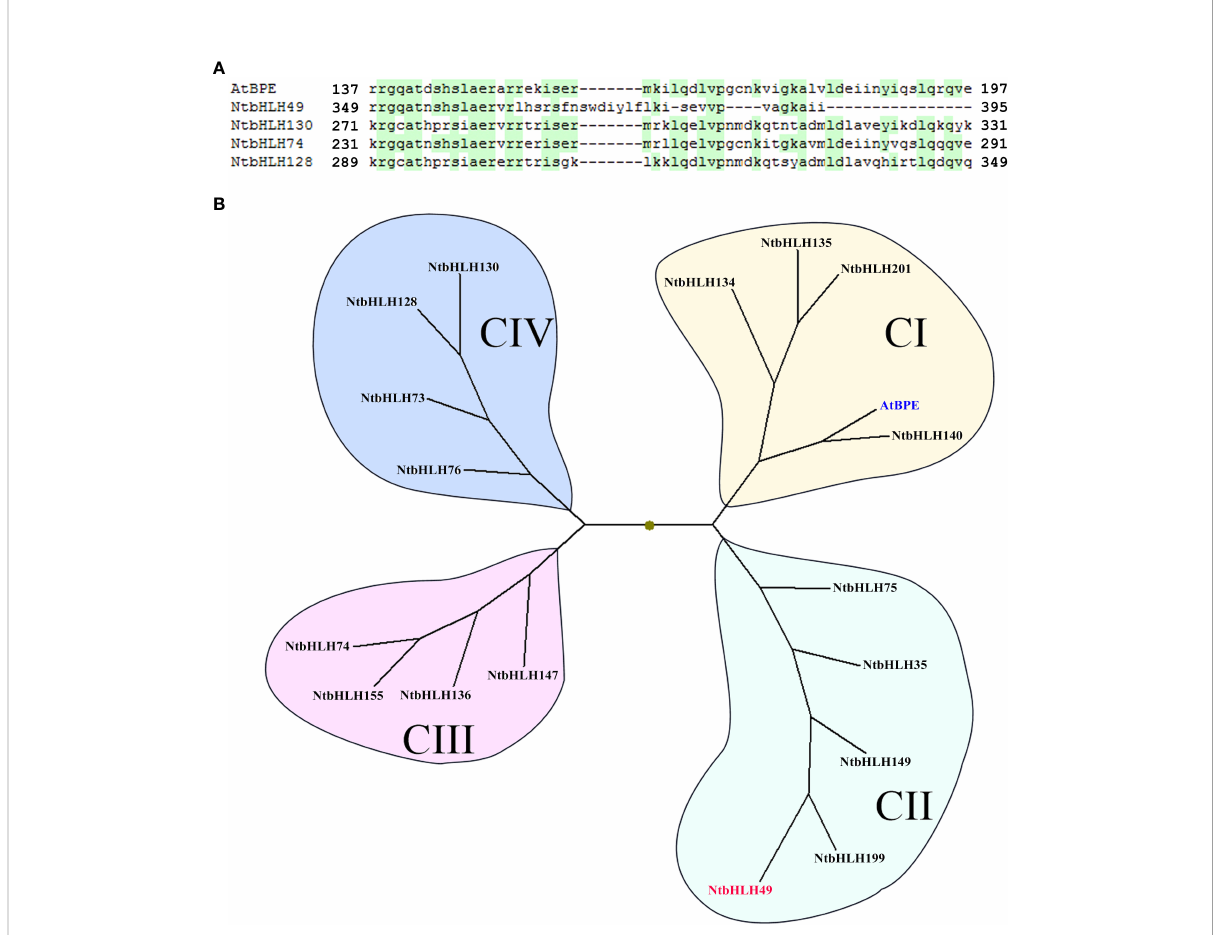
FIGURE 3 Sequence alignment (A) and phylogenetic analyses (B) of tobacco AtBPE-like transcription factors. GenBank accession for AtBPE (in blue) is NP_564749, and those for tobacco bHLHs are as followings: NtbHLH49 (in red; XM_016610531), NtbHLH130 (XM_016622848), NtbHLH74 (XM_016633998), NtbHLH128 (XM_016621558), NtbHLH201 (XP_016471633), NtbHLH199 (XP_016500166), NtbHLH134 (XP_016477426), NtbHLH135 (XP_016443360), NtbHLH136 (XP_016462422), NtbHLH140 (XP_016494316), NtbHLH147 (XP_016441121), NtbHLH149 (XP_016478982), NtbHLH155 (XP_016462240), NtbHLH35 (NP_001312938), NtbHLH73 (XP_016497820), NtbHLH75 (XP_016438666), NtbHLH76